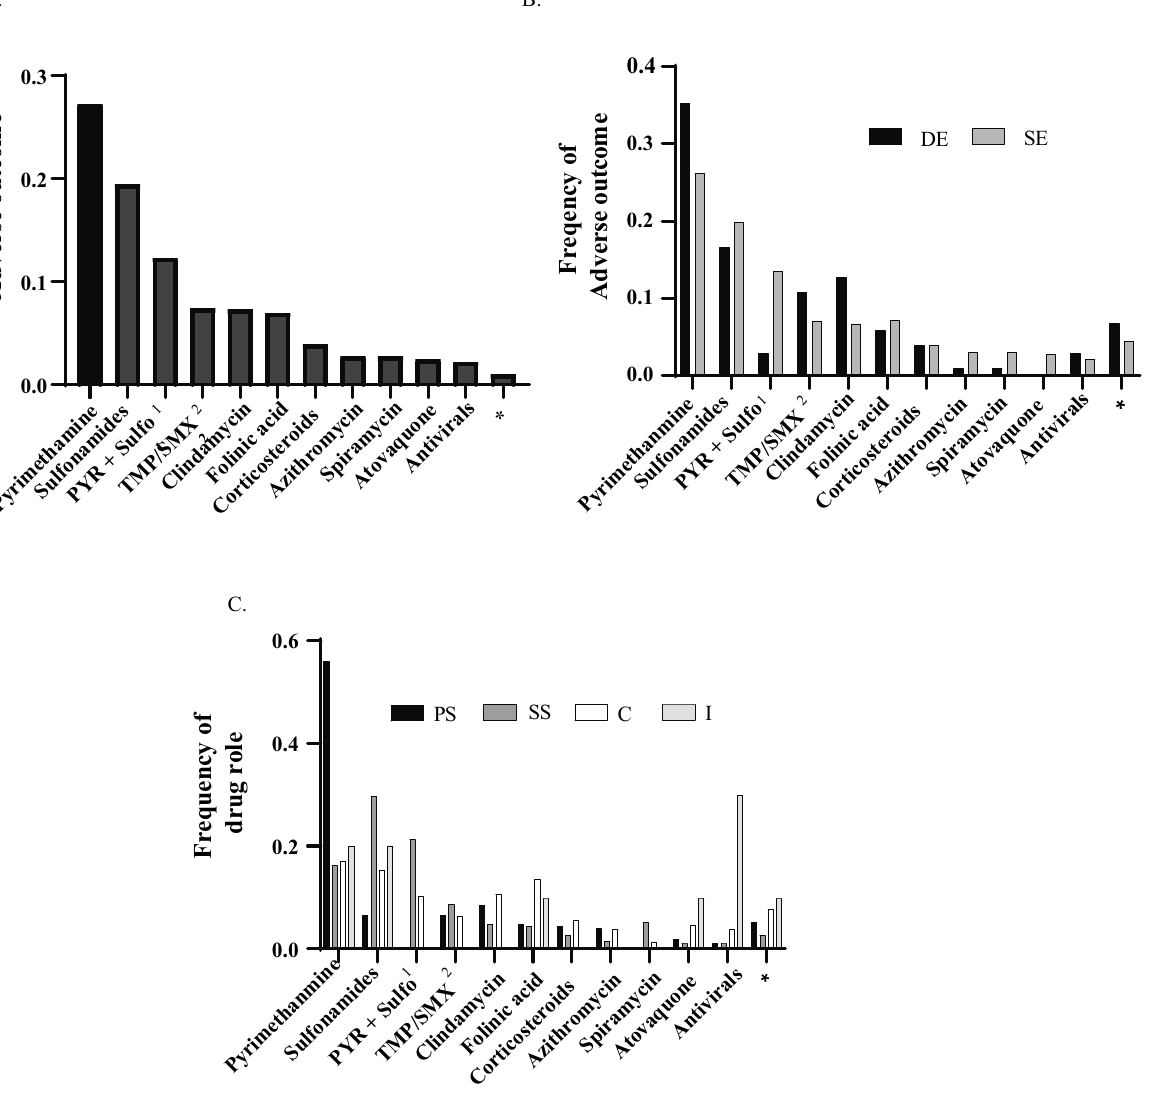
Figure 2. Drugs used in the treatment of Toxoplasma infections in FAERS database. ( A ) Drugs with > 10 adverse outcome reports. ( B ) Frequency of adverse outcome by agent/drug. ( C ) Role of the drug in the adverse outcome. (*) See table S4 for a list of drugs with < 10 adverse outcome reports. 1 pyrimethamine, 2 trimethoprim- sulfamethaxazole, Death (DE), Serious